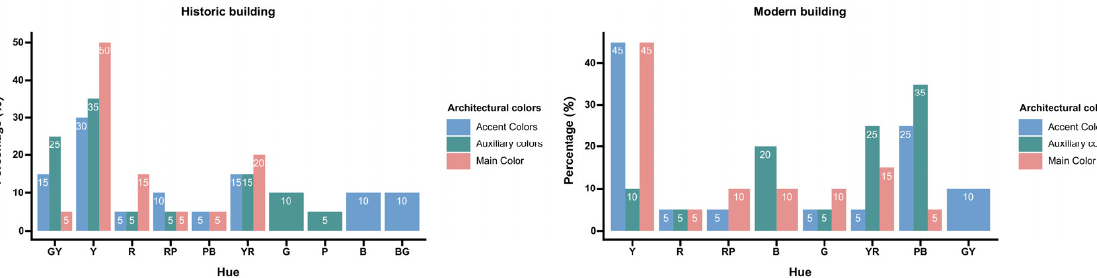
Figure 9. The color ratio of historic buildings to modern